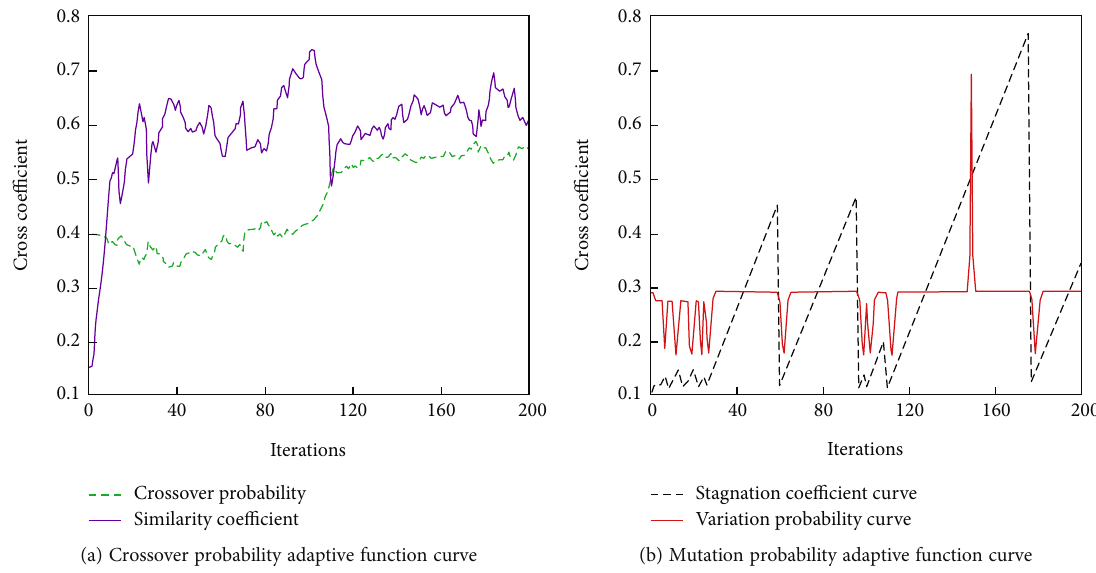
Figure 6: Crossover and genetic operators of the improved NSGA-II genetic